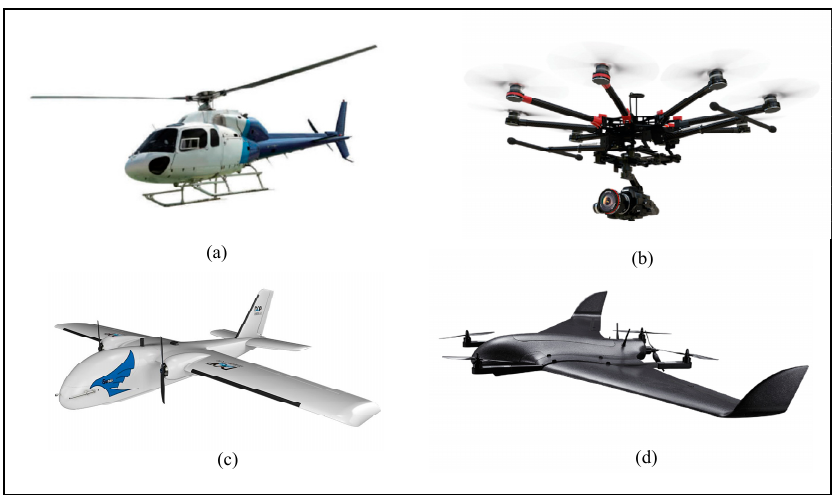
Figure 1. Typical prototypes of fixed-wing and rotary wing UAVs. ( a ) Single rotor UAV, ( b ) Multi-rotor UAV, ( c ) Fixed-wing UAV, ( d ) Hybrid